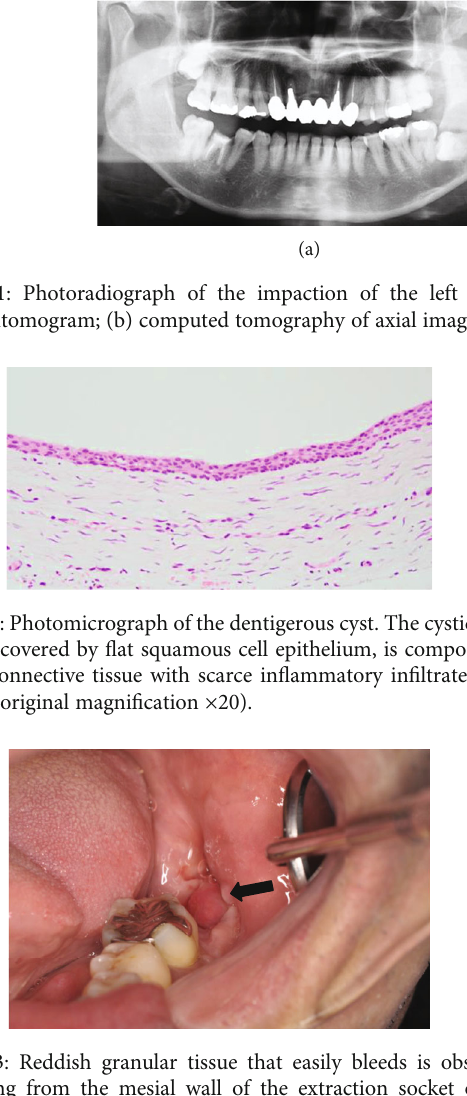
Figure 5: Photomicrograph of the mass in the tooth extraction socket. The specimen is partially covered with acanthotic squamous cell epithelium that is composed of granulation tissue with prominent small capillaries and large amounts of in fl ammatory in fi ltrate such as lymphocytes, plasma cells, and leukocytes. The endothelial cells often have plump cytoplasm (H- E staining, original magni fi cation ×